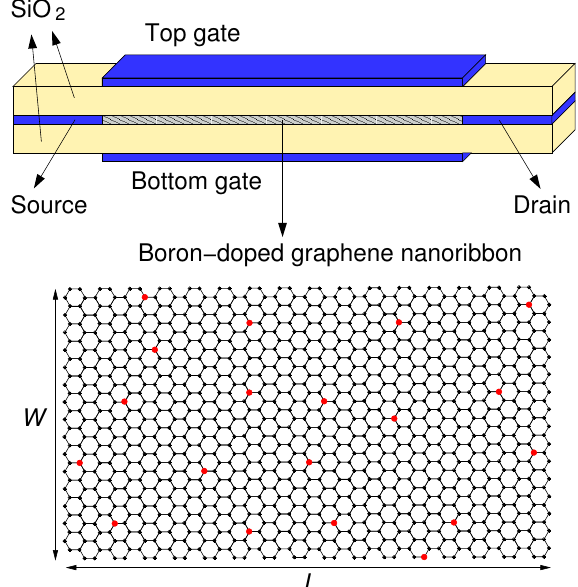
Figure 1. Sketch of the considered field-effect-transistors. The transmission channel is a boron-doped armchair graphene nanoribbon, represented at the bottom: black and red atoms are carbon and boron atoms, respectively, while the hydrogen atoms passivating the edges are not